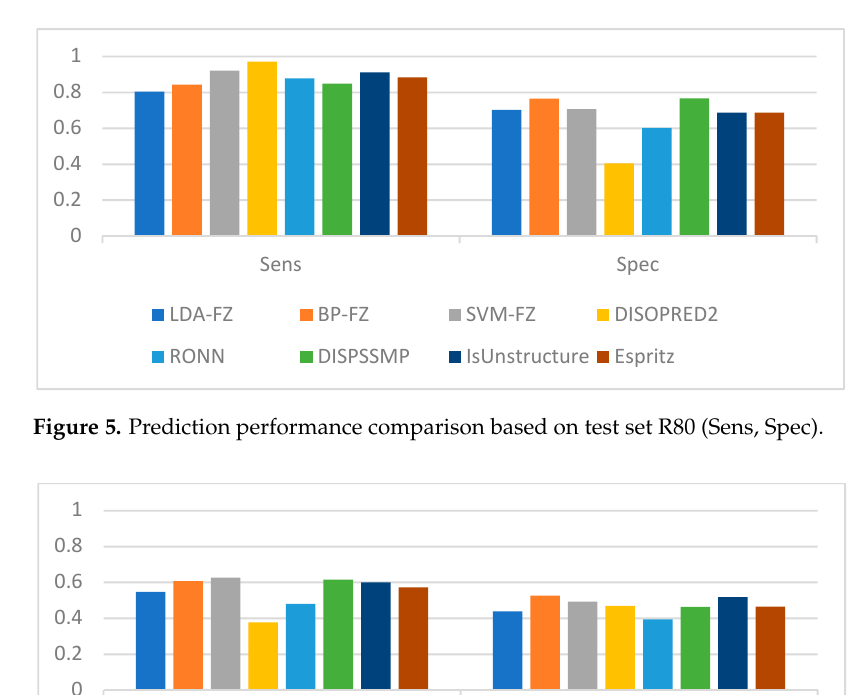
Table 8. Influence of fuzzy entropy on LDA-FE prediction results.